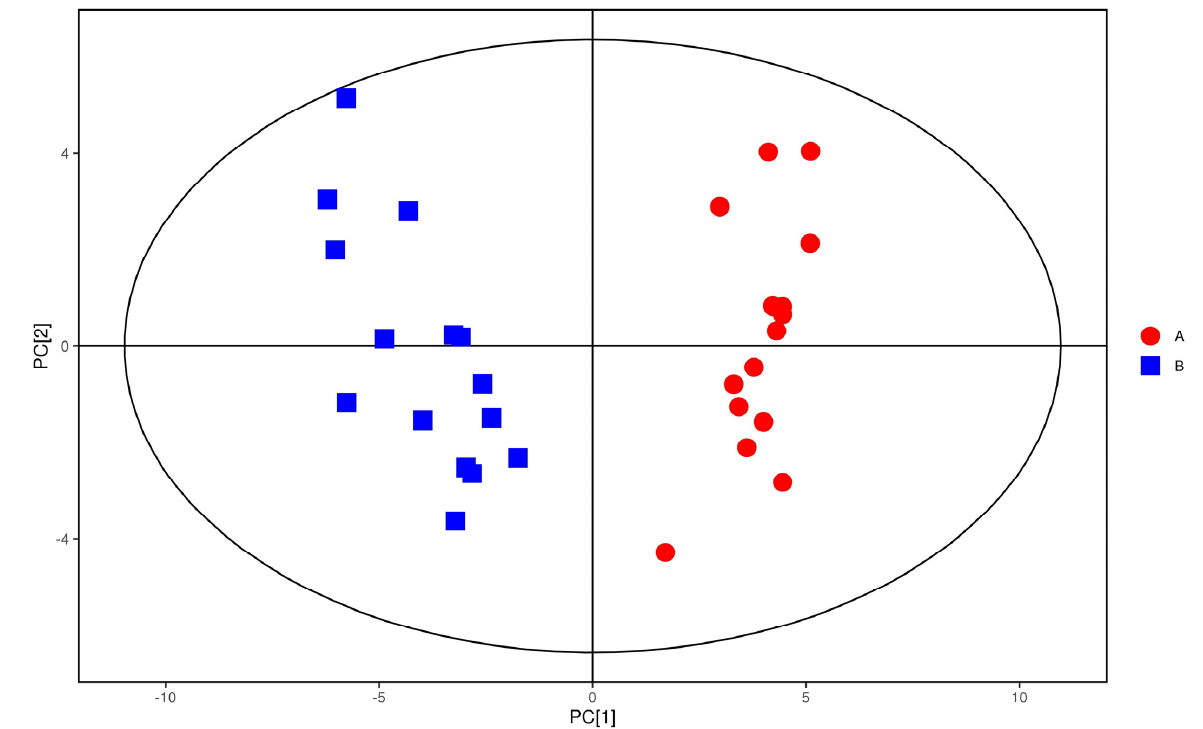
Figure 6. OPLS − DA score of positive ions. Red dots represent the control group. Blue dots represent the study group.